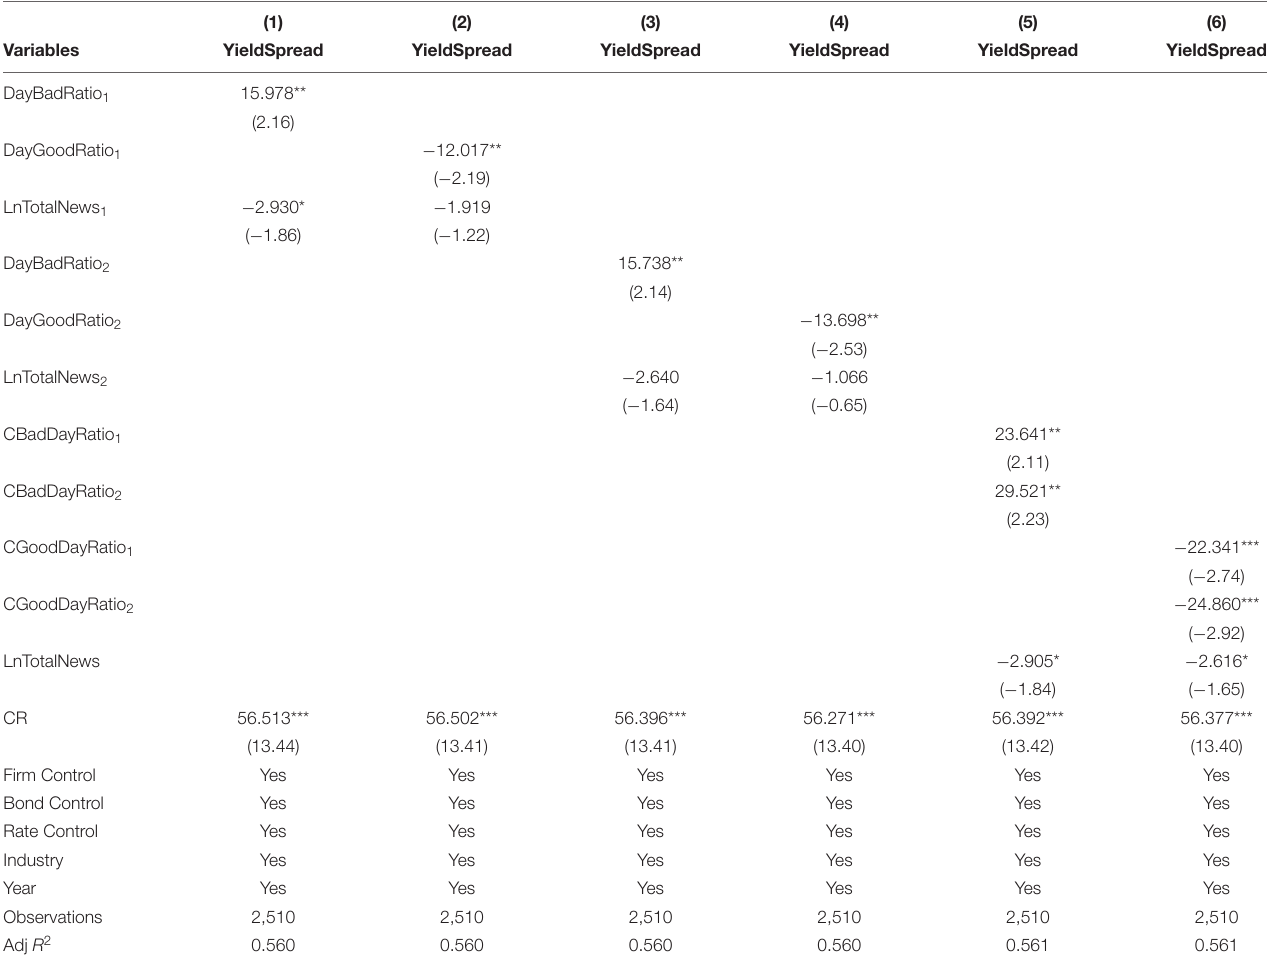
TABLE 7 | Investor reaction to old news and new